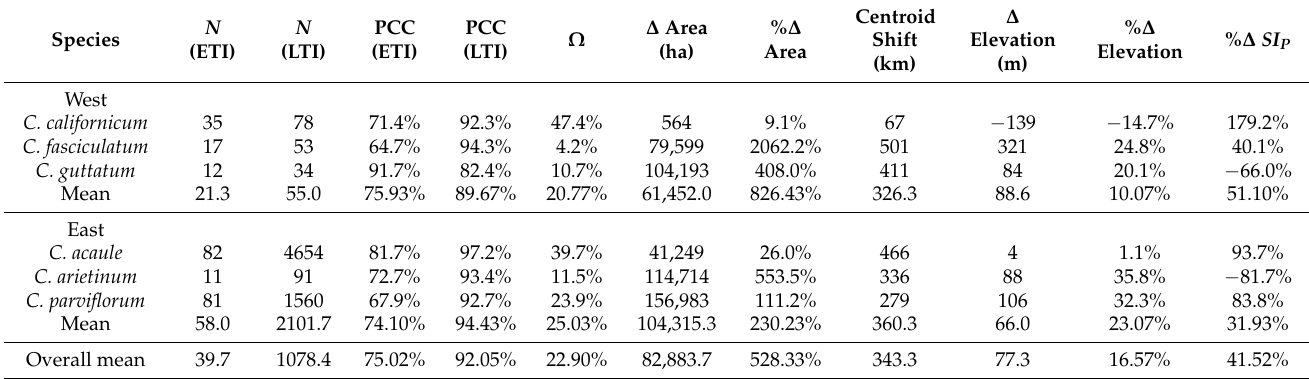
Table 1. Summary statistics from species distribution models for six North American Cypripedium species for the early (ETI; 1980 to 1989) and late time intervals (LTI; 2010 to 2019). Measures in- clude the number of occurrence records included in model construction (N), percent of records correctly predicted (PCC), overlap criterion ( Ω ), change in total area of suitable habitat between time intervals ( ∆ area), percent change in total area (% ∆ area), distance the centroid of suitable habitat shifted, change in mean elevation of suitable habitat ( ∆ elevation), percent change in mean elevation (% ∆ elevation), and percent change in Patton’s shape index (% ∆ SI P ), which is an estimate of change in degree of habitat